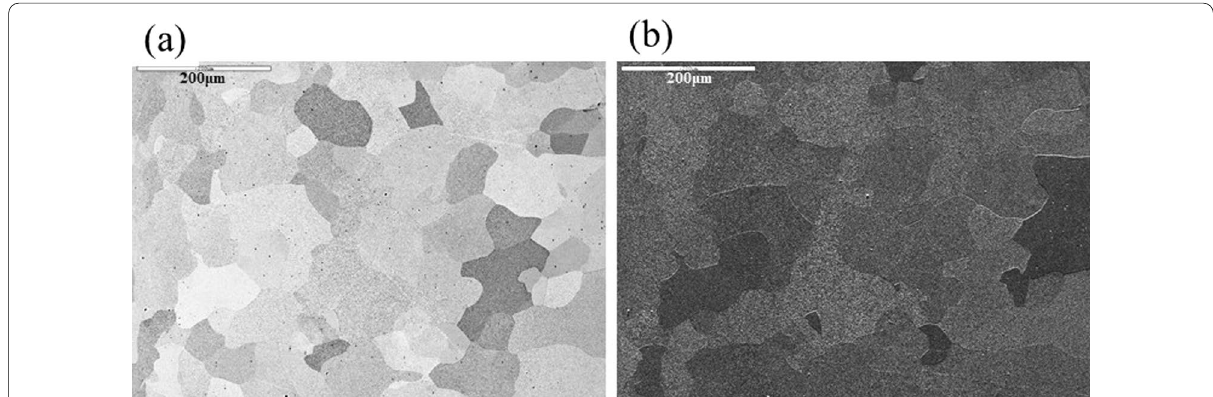
Fig. 3 The backscattered electron (BSE) image ( a ) and secondary electron image (SEI) ( b ) of the etched iron starting material